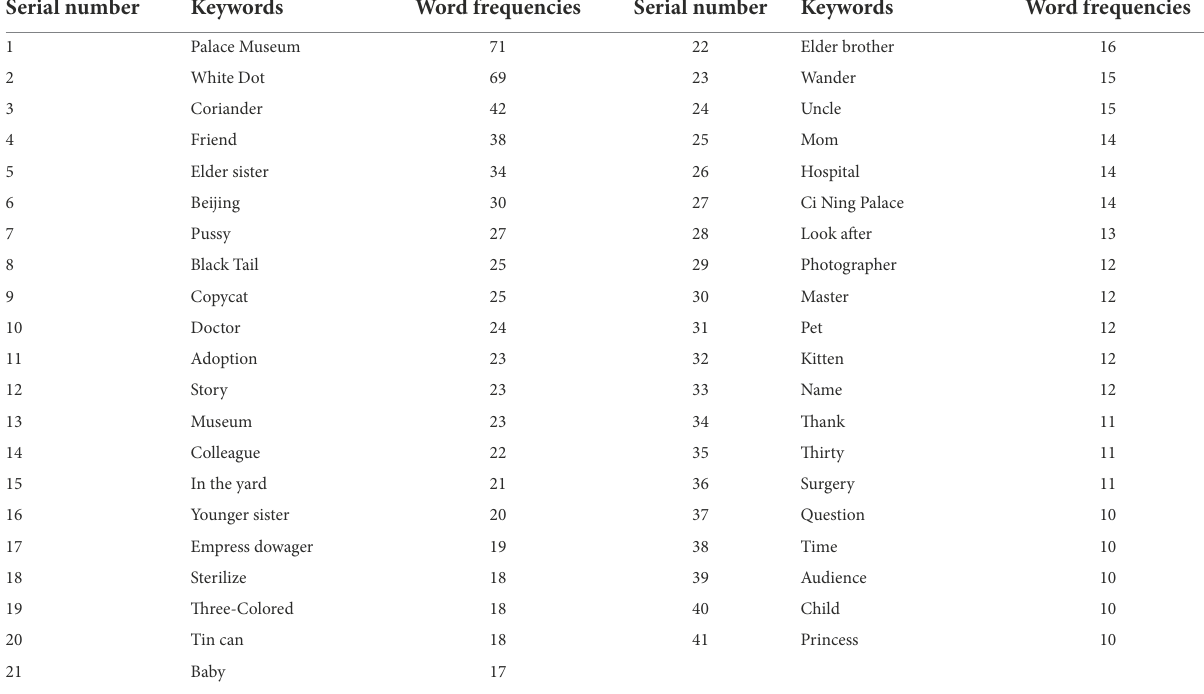
TABLE 2 List of high-frequency words and the word frequencies in the microblog